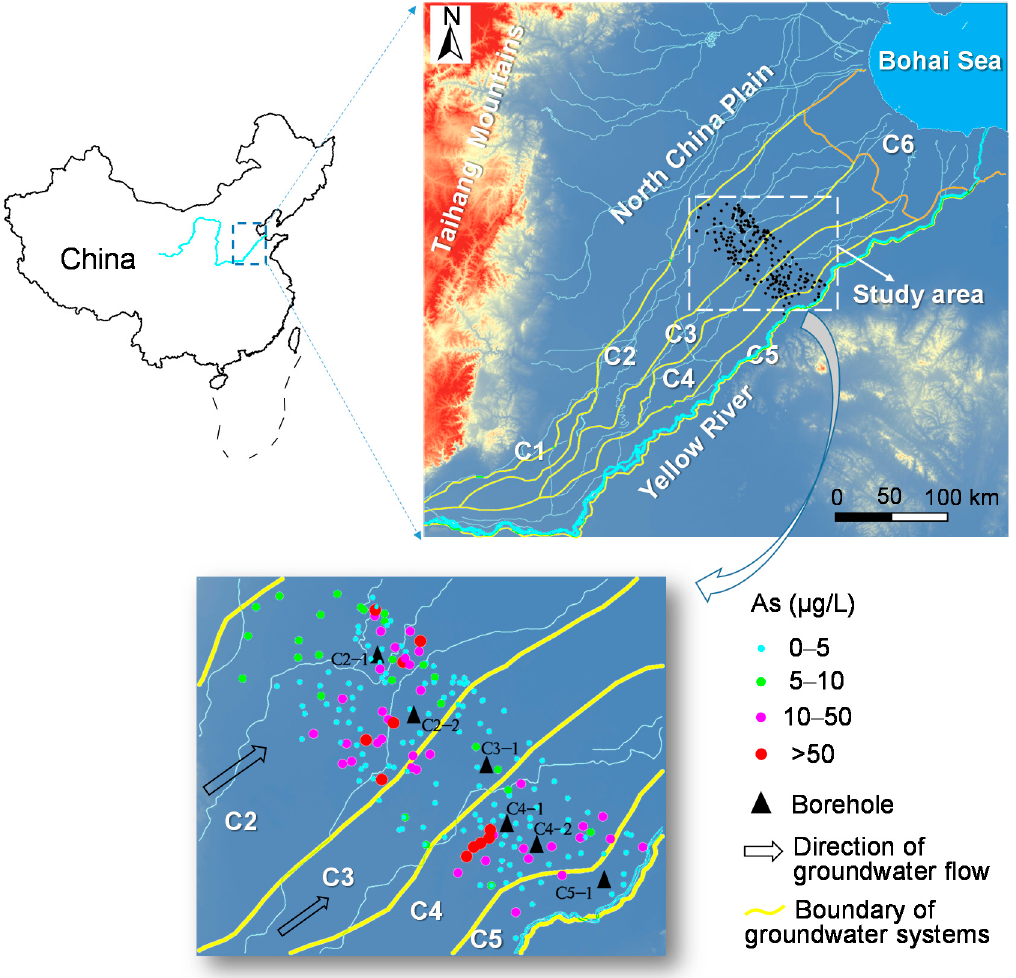
Figure 1. Locations of the study area and arsenic concentration distribution in the different groundwater systems in the lower Yellow River. C2 is the southern Neihuang–Guanxian–Ningjin paleochannel system; C3 is the Fuyang–Gaotang– Yangxin paleointerfluve system; C4 is the Liaocheng–Linyi paleochannel system; C5 is the modern Yellow River affected zone